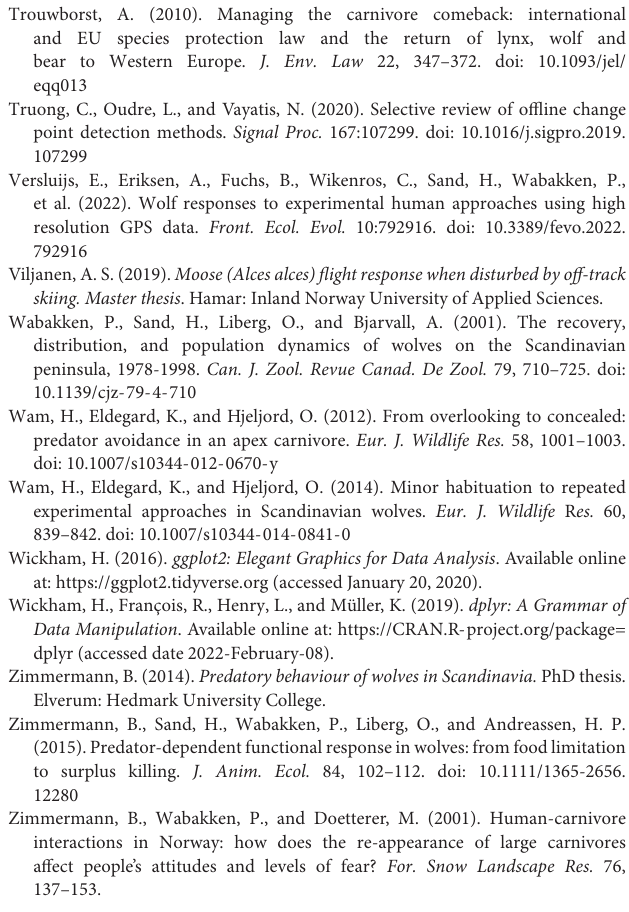
tableViewLayout1/ (accessed October 1, 2021). Støen, O.-G., Ordiz, A., Evans, A. L., Laske, T. G., Kindberg, J., Fröbert, O., et